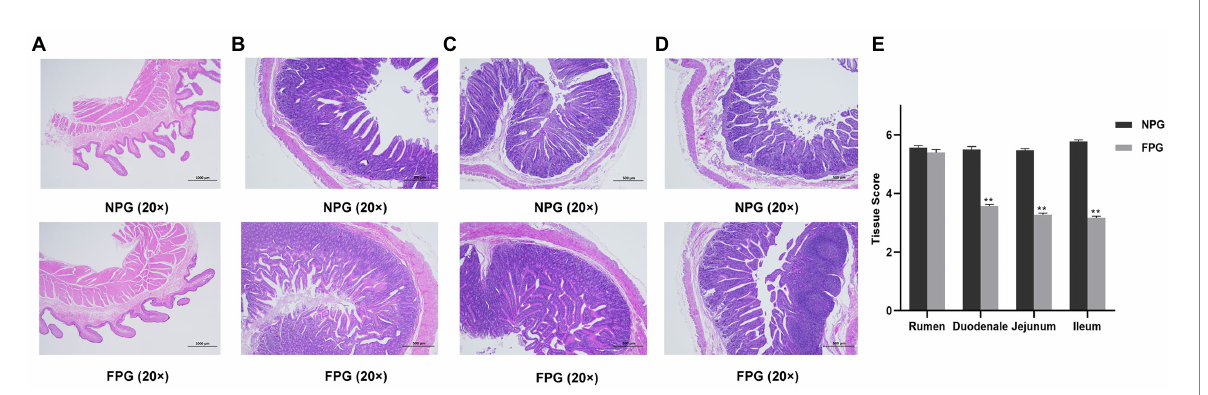
FIGURE 2 Histologic section analysis of gastrointestinal tract of Boer goats was performed at 20 × and 40 × low magnification. (A) the rumen tissue (20× magnification); (B) the duodenal tissue (40× magnification); (C) the jejunum tissue (40× magnification); (D) the ileum tissue (40× magnification); (E) the tissue score. Data are expressed as mean ± SD ( n = 3). * p < 0.05 and ** p < 0.01 compared with the NPG group.